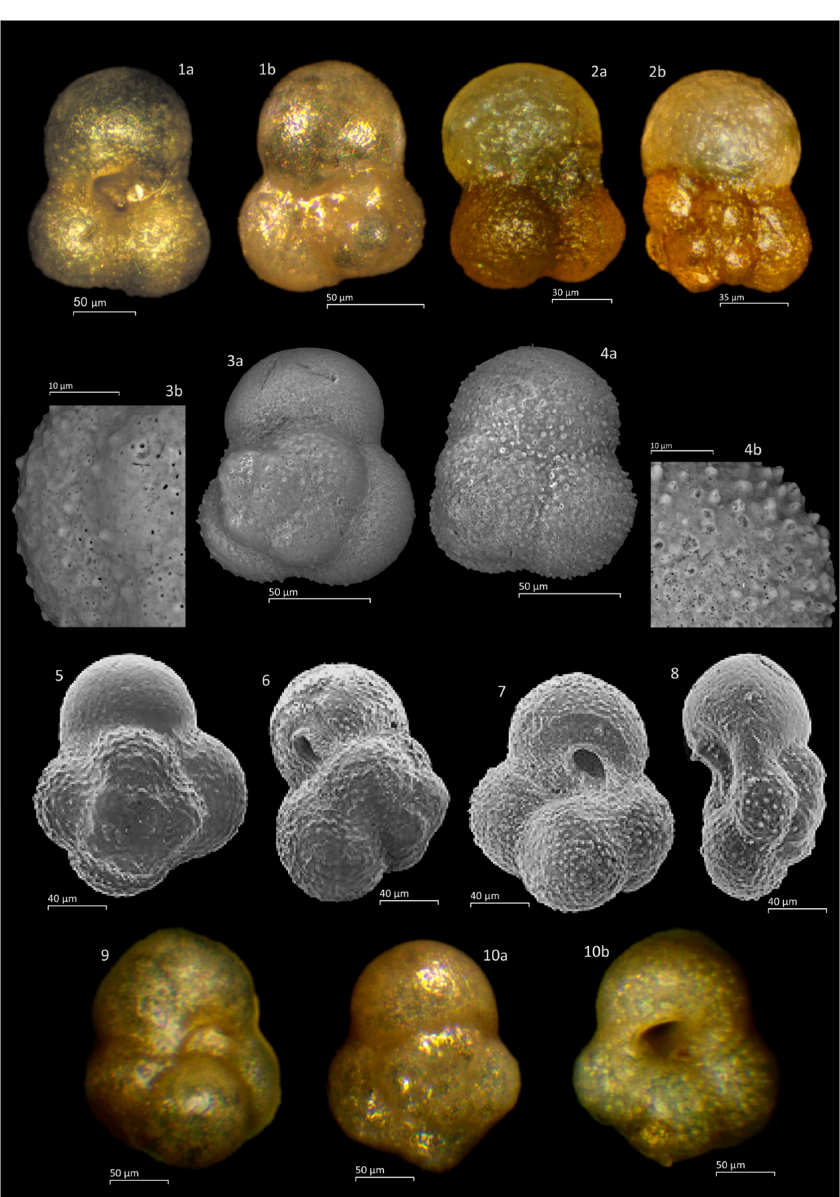
Figure A1. Globuligerina glinskikhae Gradstein and Waskowska. Subfigures 1a , b —holotype, sample 6, Morrisi Ammonite Zone, Middle Bathonian, Gnaszyn, Poland. Subfigures 2a , b —paratype, sample 8, Parkinsoni Zone, Upper Bajocian, Khouroukra, Dagestan. Subfigures 3a , b and 4a , b —paratypes, sample 6, Morrisi Zone, Middle Bathonian, Poland; note the microperforate and pustulose wall with scattered pore mounds. Globuligerina oxfordiana (Grigelis). Subfigures 5 – 7 , Oxfordian of Upper Volga, Russia. Subfigure 8 , Mariae Zone, Lower Oxfordian near Le Havre, France (subfigures 5–8 from [3]). Subfigures 9 and 10a , b , sample 6, Morrisi Zone, Middle Bathonian,